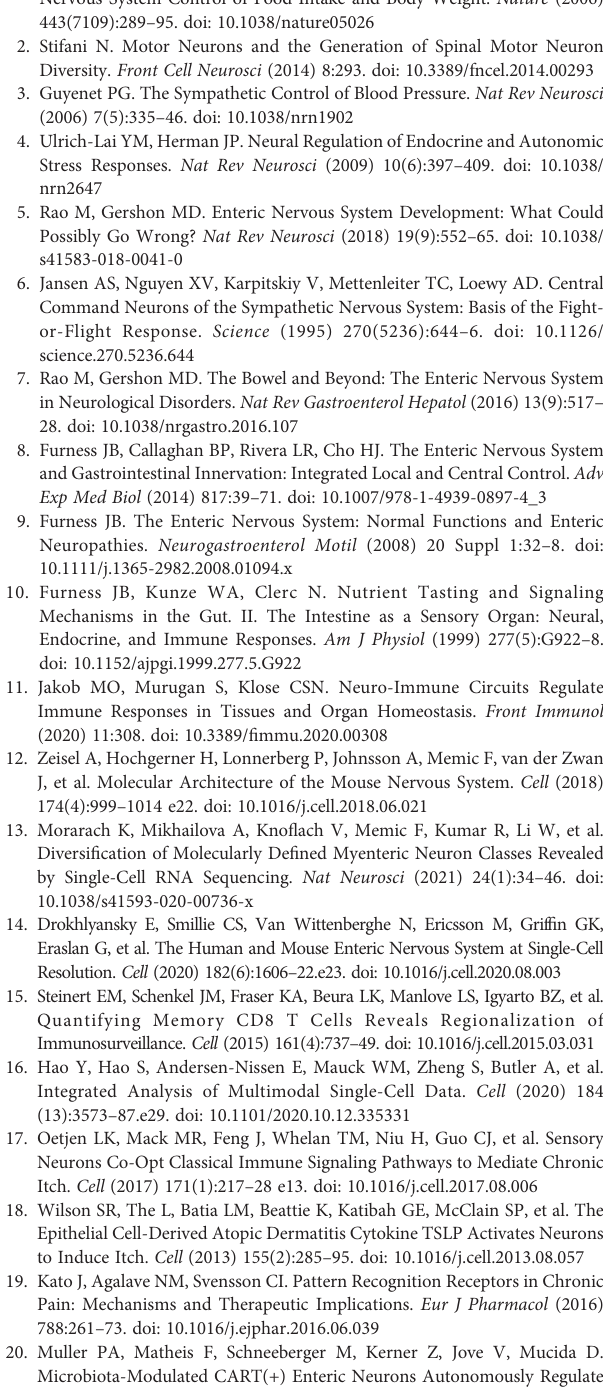
receptorandothergenesofinterest.Datawasdownloadedfromhttp://mousebrain.org/ (12) or from https://singlecell.broadinstitute.org/ (14). Genes not present in the plot showing the Drokhlyanski data have been fi ltered. All dataset were normalized and transformed before the plots were created using the Seurat package